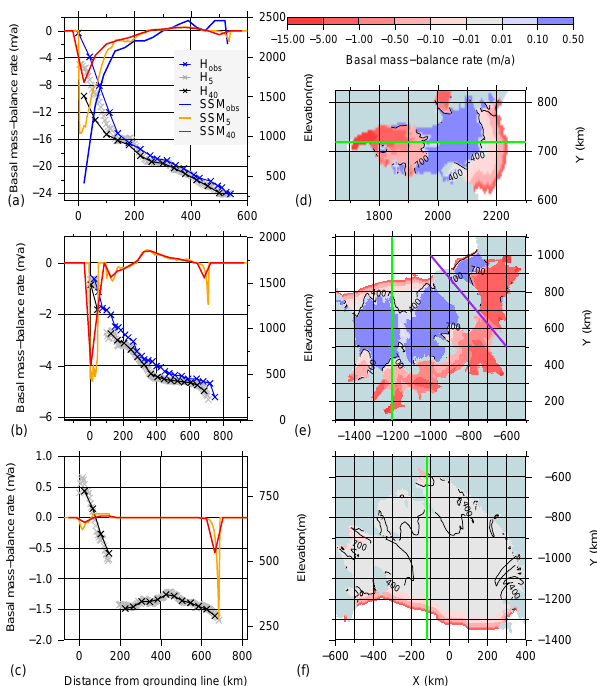
Fig. 5. Transects of thickness and observed/computed melt rates, and computed spatial melt maps for the three major shelves: AMY (a, d) , ROS (b, e) , RON-FIL (c, f) computed from the SSM law with unity parameters (see text). H obs , H 5 , and H 40 are the thicknesses from the observed, ALBMAP 5 , and ALBMAP 40 datasets. SSM obs is the observed melt rates. SSM 5 and SSM 40 are the computed melt rates based on the respective ALBMAP thicknesses. Green line on the melt maps shows the locations of the transects. The purple line demarcates the divide between the FIL and RON shelves at 47 ◦ W. The black contours highlight the observed 400 and 700 m thickness